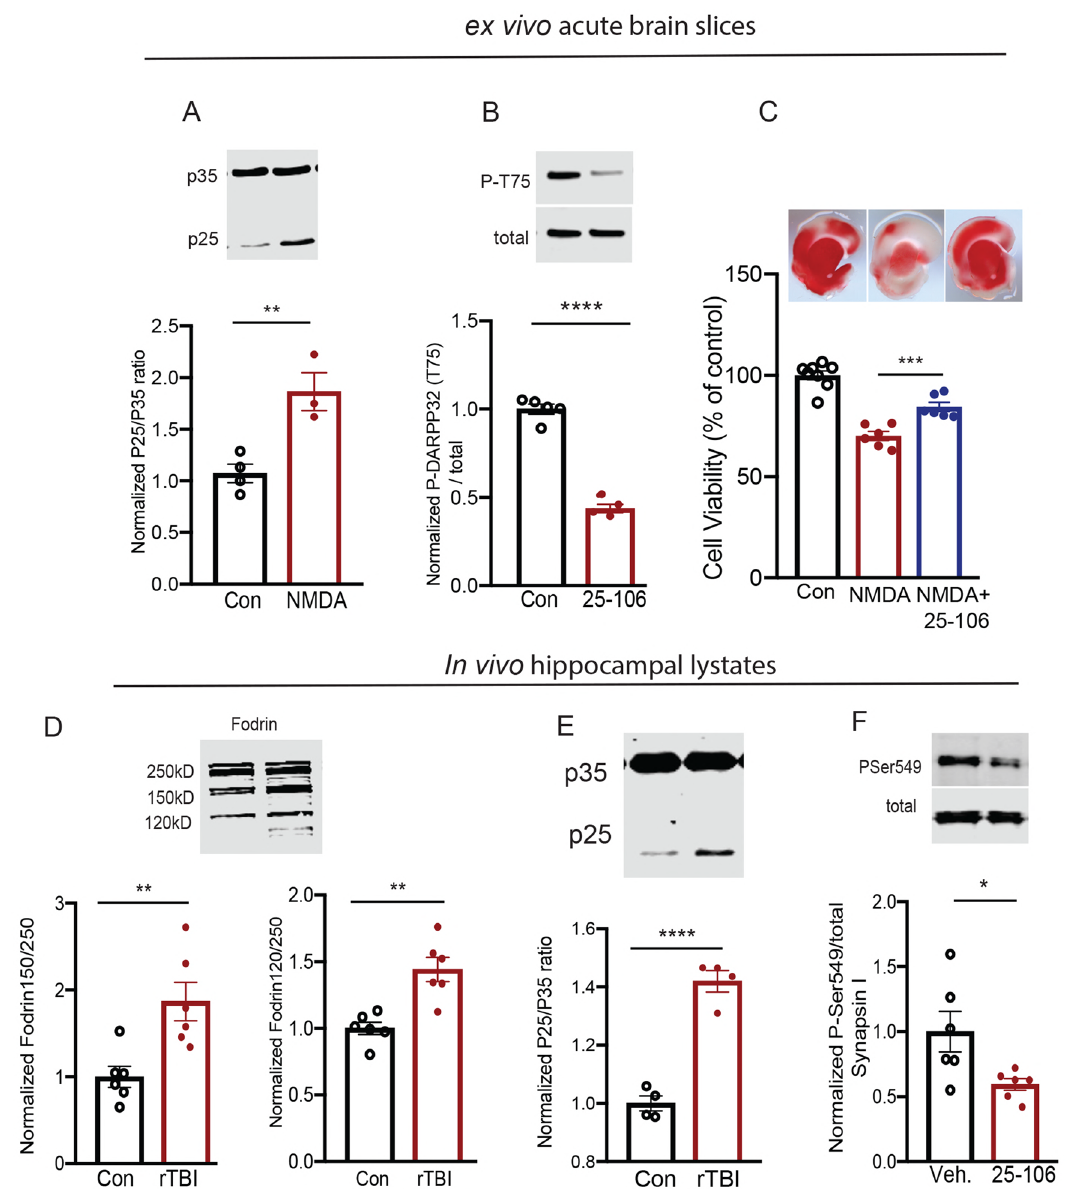
Figure 5. rTBI and excitotoxicity evoke aberrant Cdk5 activity and Cdk5 inhibition is protective. ( A ) Quantitative immunoblot analysis of acute brain slices for p35/25 after NMDA/Glycine (100/50 µM,